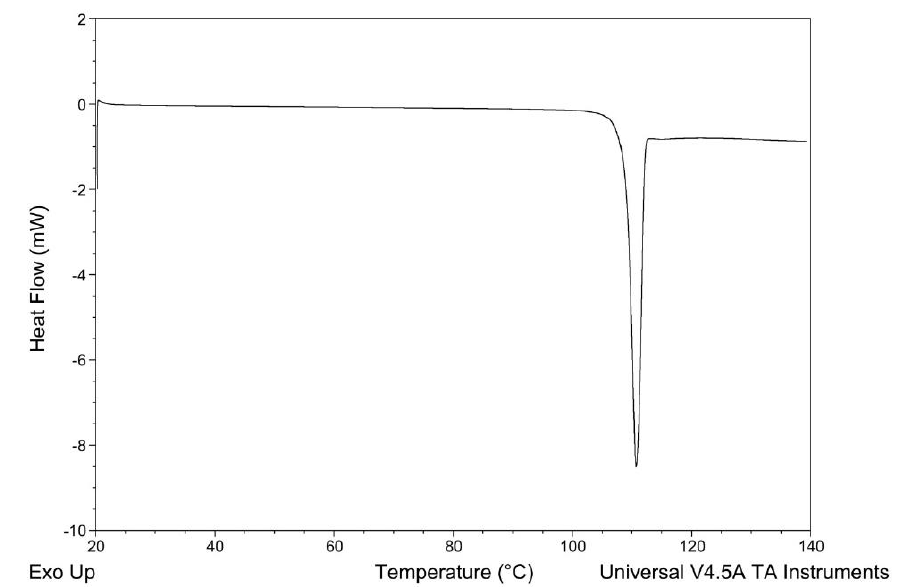
Figure 1. Di ff erential scanning calorimetry (DSC) profile of pure N-acetylcysteine (NAC). DSC profiles both of physical mixture NAC:resveratrol:cyclodextrin (10:15:75 w:w, MF) and of